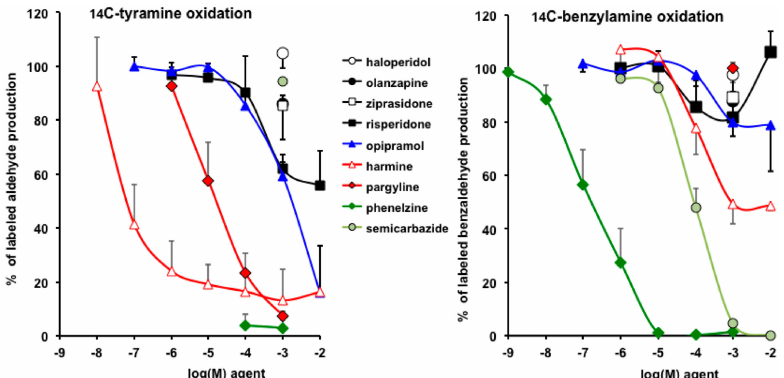
Figure 7. Influence of typical antipsychotics (haloperidol), atypical antipsychotics (olanzapine, ziprazidone, risperidone), MAO inhibitor antidepressants (phenelzine, pargyline), tricyclic antidepressants (opipramol), and various inhibitors (harmine, semicarbazide) on [ 14 C]-tyramine and [ 14 C]-benzylamine oxidation by human white adipose tissue. Homogenates (approximately 100 µ g protein / 100 µ L) were preincubated for 15 min with the indicted agents, then incubated for 30 min in the presence of 0.5 mM [ 14 C]-tyramine (left panel) or 0.5 mM [ 14 C]-benzylamine (right panel). For each amine, results are expressed as respective oxidation without added agent (100%). Each point is mean ± SEM of four to nine